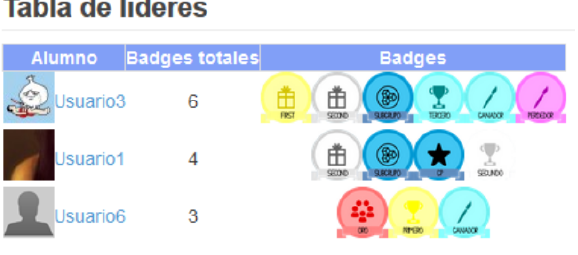
Figure 4. Leaders table.